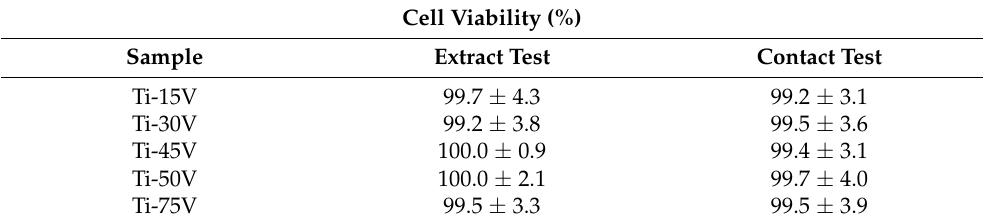
Table 5. Cell viability after a contact and extract test was performed on the anodic colored